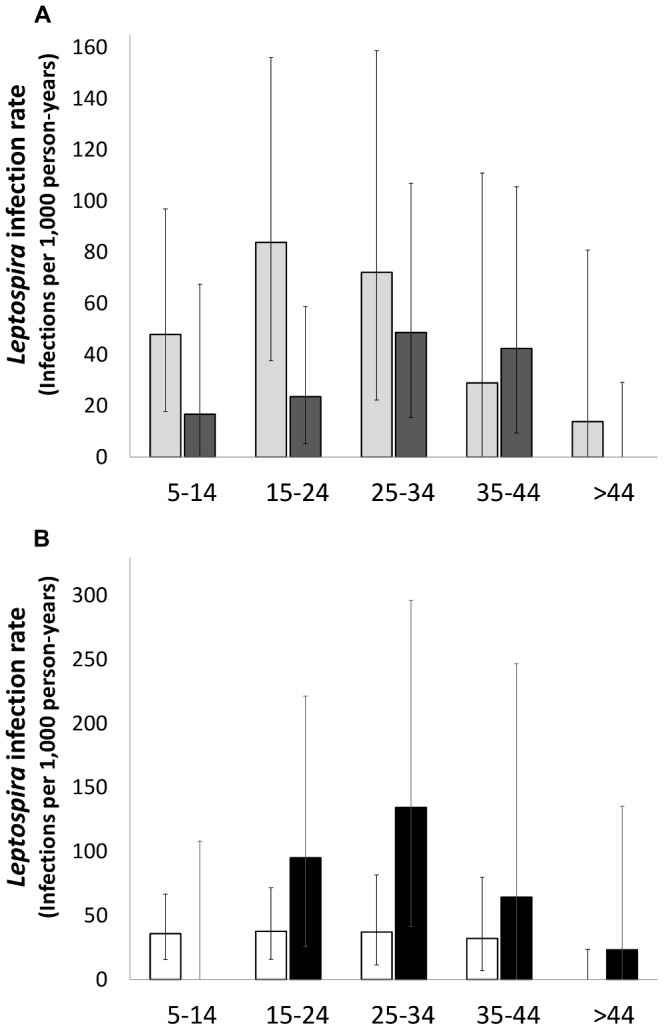
Age-specific attack rates for A) overall Leptospira infection according to gender [light grey bars, male; dark grey bars, female], and B) primary and secondary Leptospira infection rates [open bars, primary infection; black bars, secondary infection].Whiskers indicate the 95% Confidence Interval for the rate, adjusted for the survey design. The x axes refer to age groups in years. Rates in y axes are shown as infections per 1,000 person-years